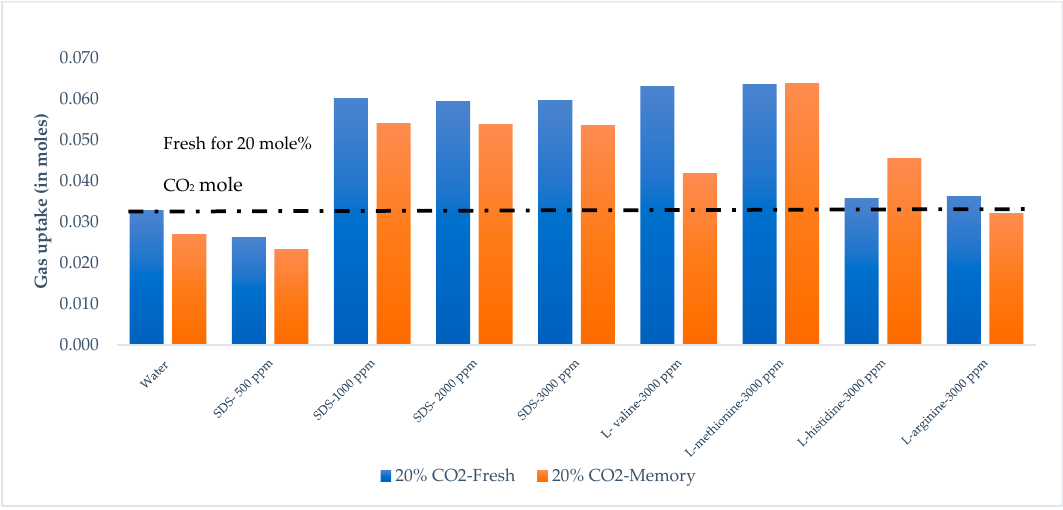
Figure 5. Gas uptake (Fresh and Memory)-20% CO 2 : Gas uptake analysis for 20% CO 2 and effect of surfactant and different amino acids on the gas uptake for flue gas hydrate formation (20% CO 2 ) measured during an isothermal experiment conducted at 120 bar and 1 °C recorded both for fresh and memory samples.